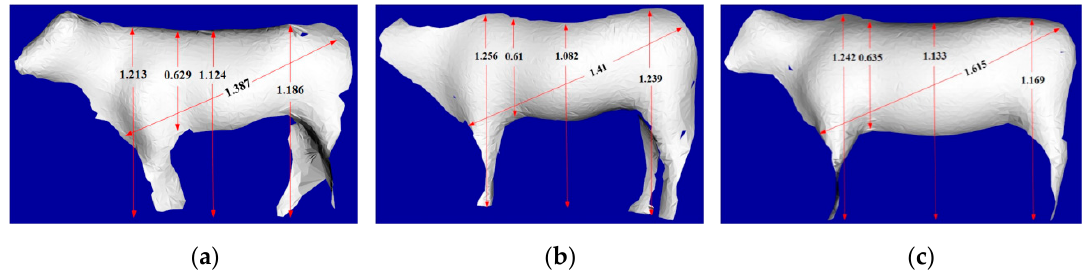
Figure 12. Automatic measurement results of the body dimensions of three live Qinchuan cattle: ( a ) Cattle Q0392; ( b ) Cattle Q0526; ( c ) Cattle Q0456.